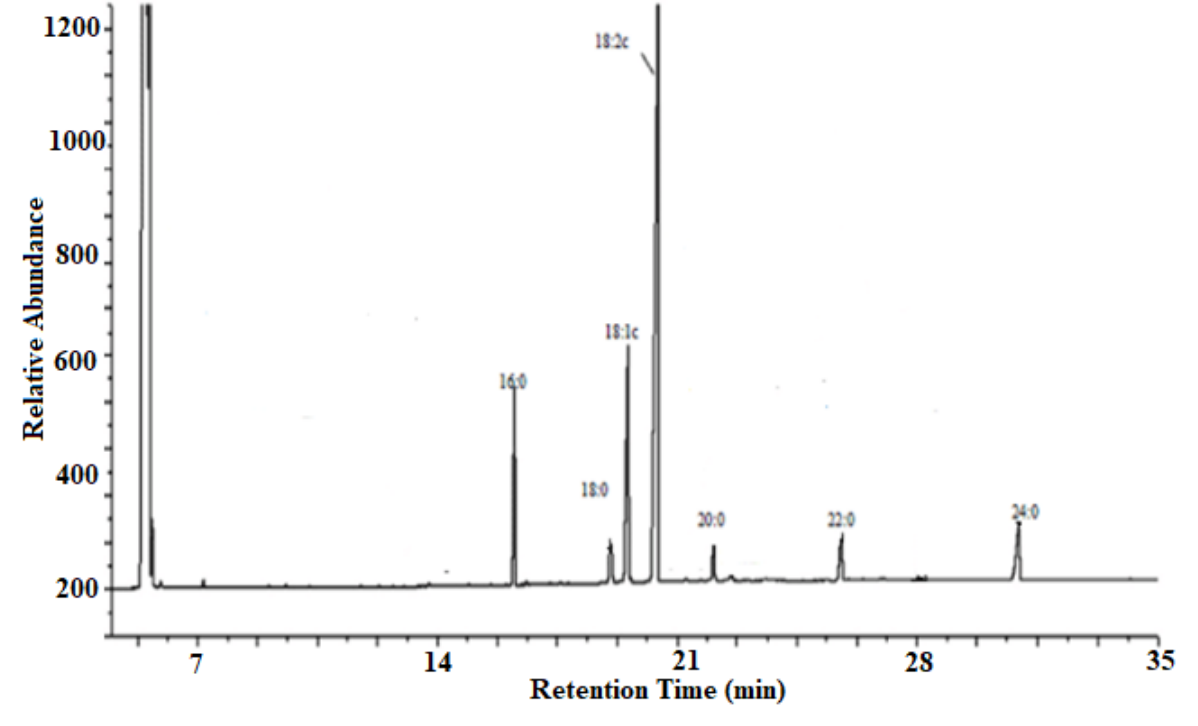
Figure 1. Representative GC FID Chromatogram of Tamarindus indica seed oil exhibiting the molecu- lar composition.